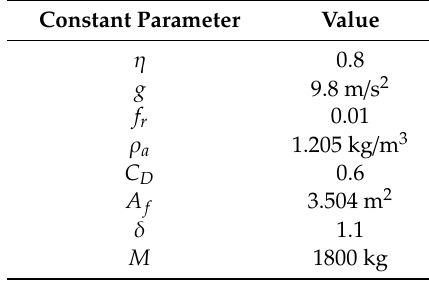
Table 4. Values of the constant parameters in the energy consumption